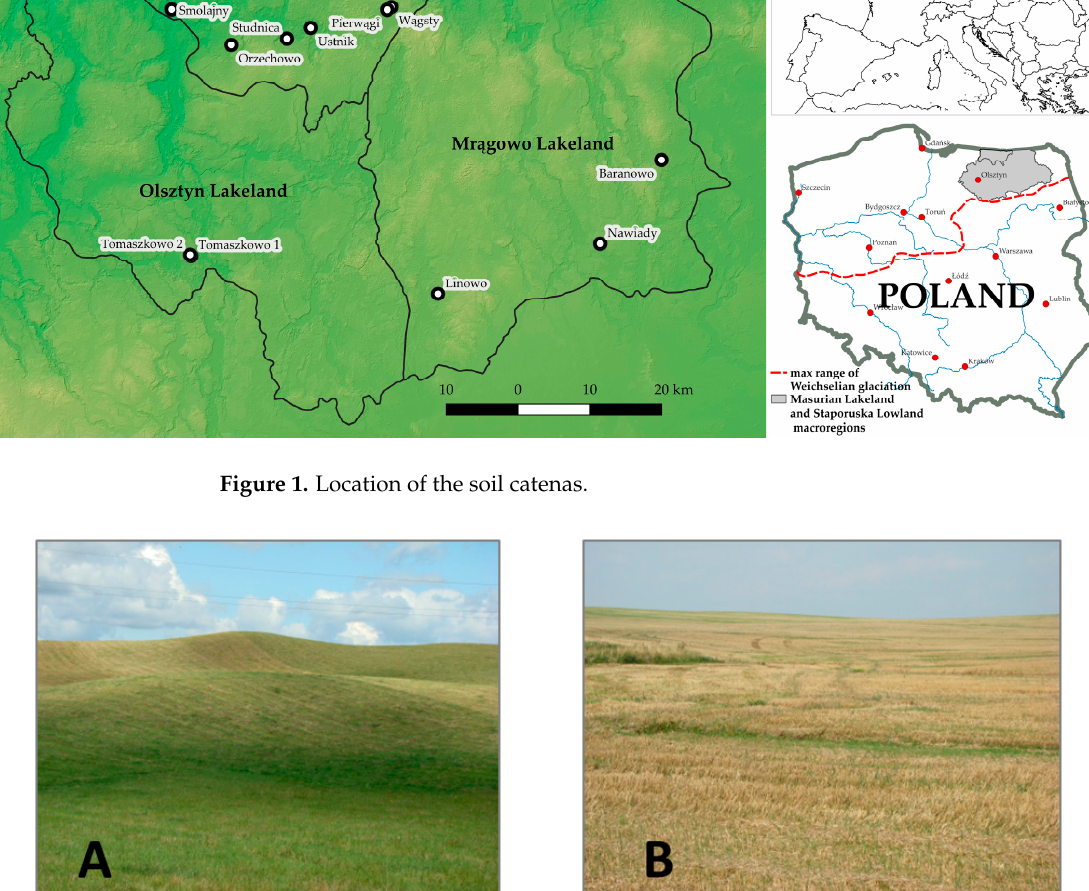
Figure 2. Types of young glacial landscapes: A —moraine, B —ice-dammed lakes.